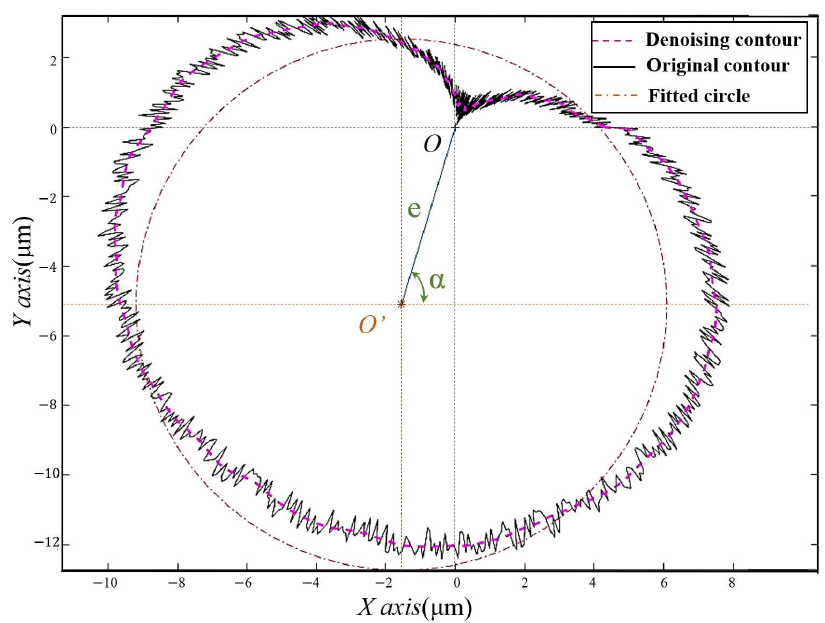
Figure 5. Graph of circumference data after processing.